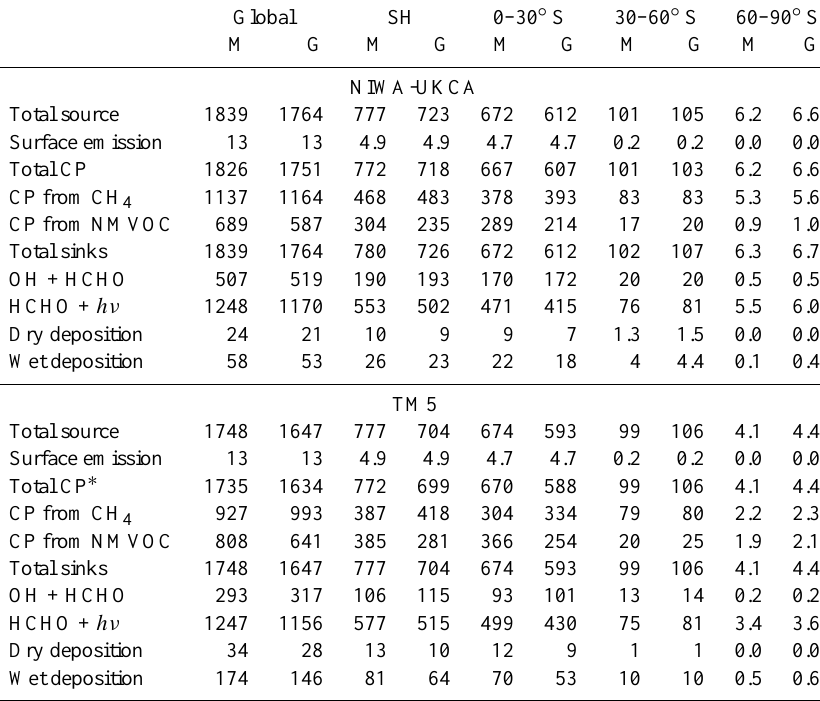
Table 5. Tropospheric HCHO budget for year 2004. Units in Tg(HCHO)yr − 1 .